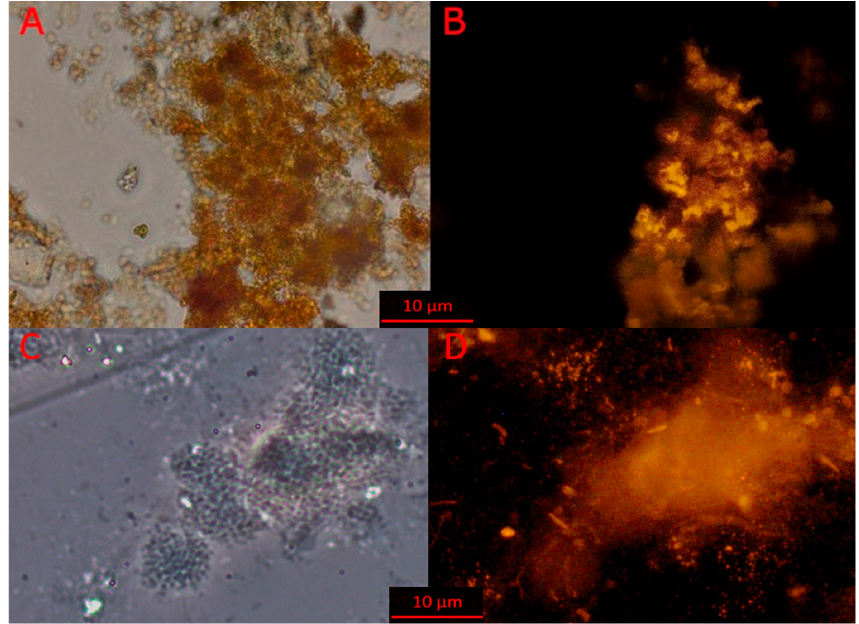
Figure 3. Phase-contrast ( A , C ) and fluorescent ( B , D ) microscopic images of microbial communities of groundwater ( A , B ) and a laboratory bioreactor ( C , D ). Scale bar 10 µm.